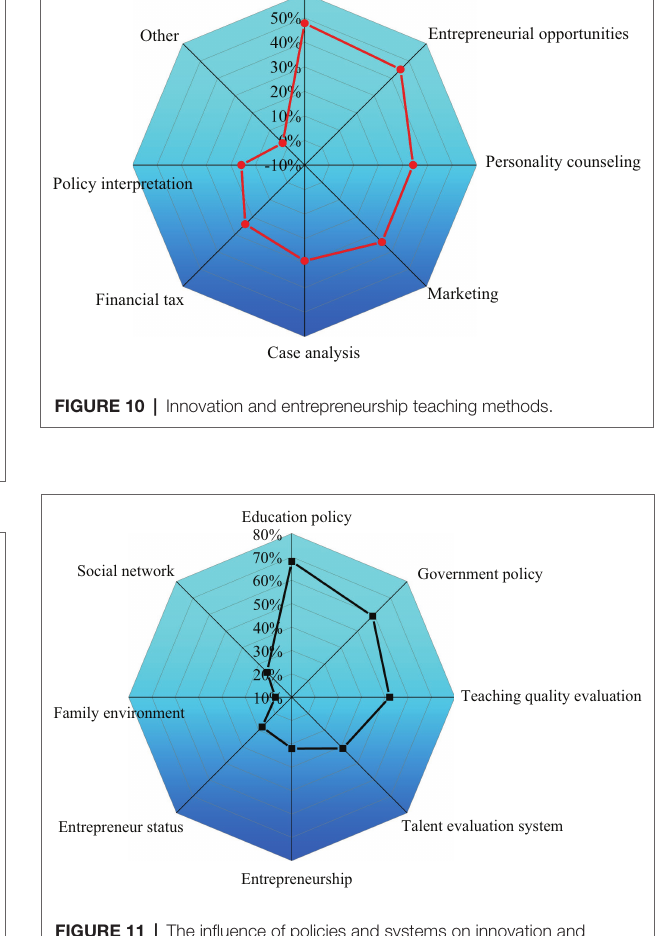
FIGURE 11 | The influence of policies and systems on innovation and entrepreneurship.